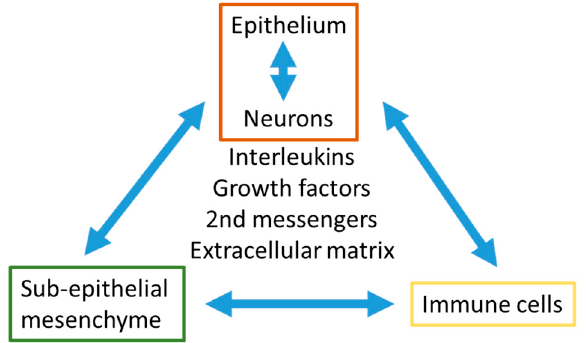
Figure 1. The interactions between the epithelium and neurons with sub-epithelial mesenchymal cells (airway smooth muscle cells, fibroblasts, myo-fibroblasts) and immune cells have to be seen as a unit, which regulates its function by secreted interleukins, growth factors, secondary messenger peptides, and the local composition of the extracellular